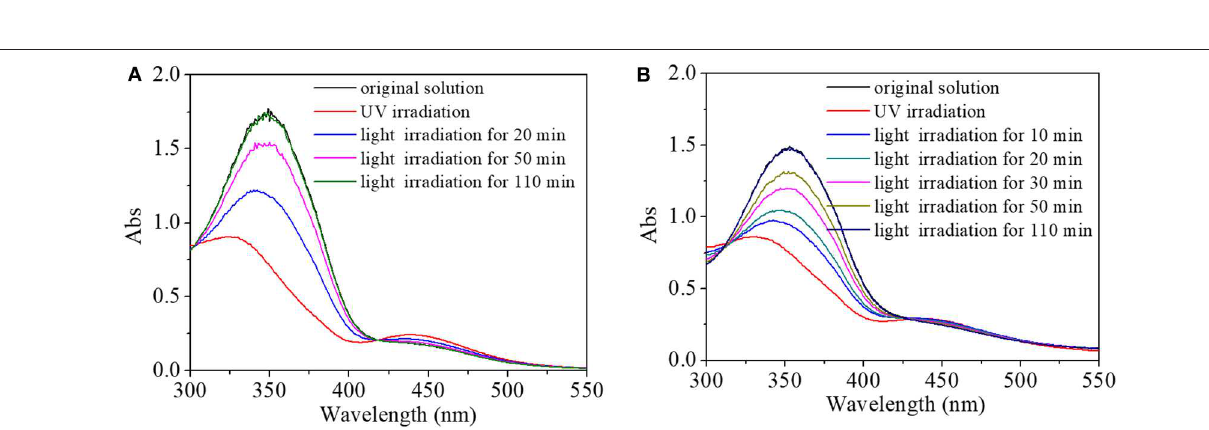
quick response time of 30 s and operable recovery time of 110 min indicated its good performance as a photoswitch. For